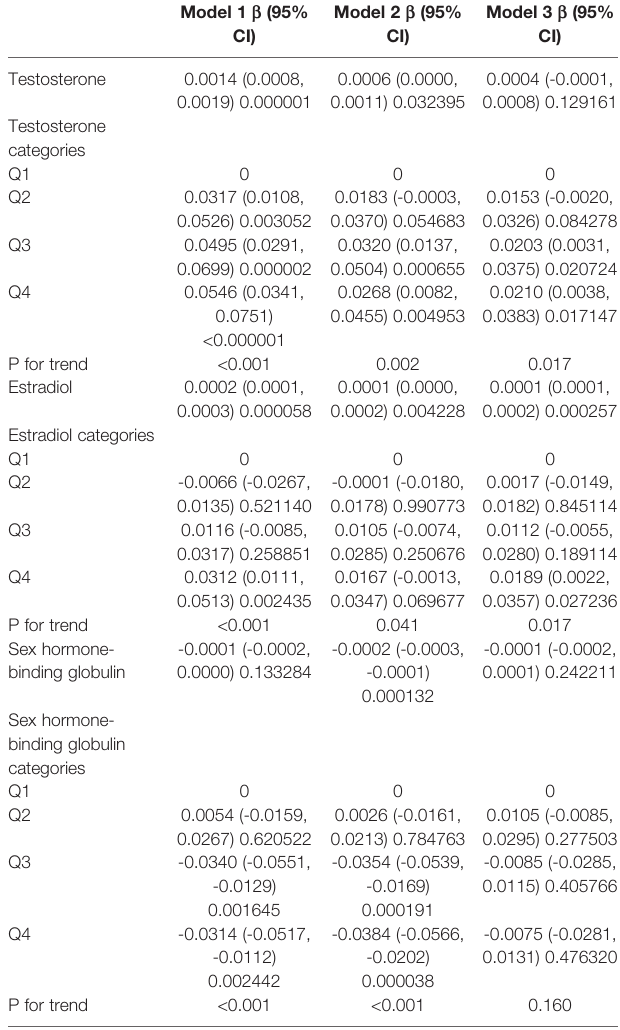
TABLE 4 | Association of serum testosterone, estradiol, and sex hormone- binding globulin levels with total bone mineral density in girls.